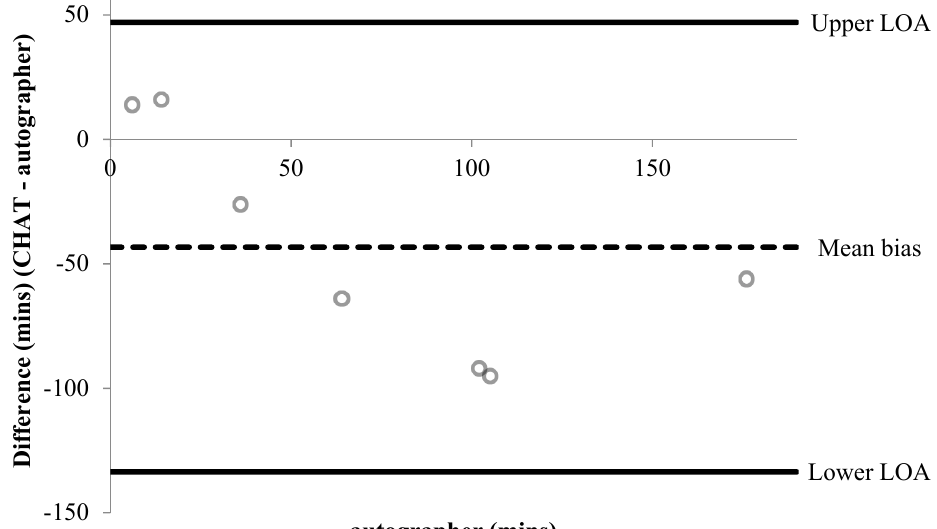
Figure 4. Bland–Altman plot demonstrating the difference between self-reported and autographer- derived after school screen time ( n = 7). A mean bias of − 43 min (±46 min) with LOA of +47 and − 134 min is shown.